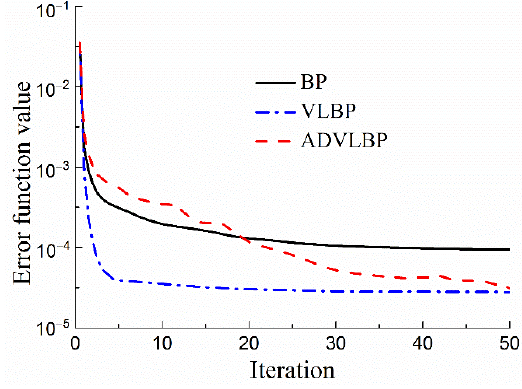
Figure 20. Transient trajectories on the map.